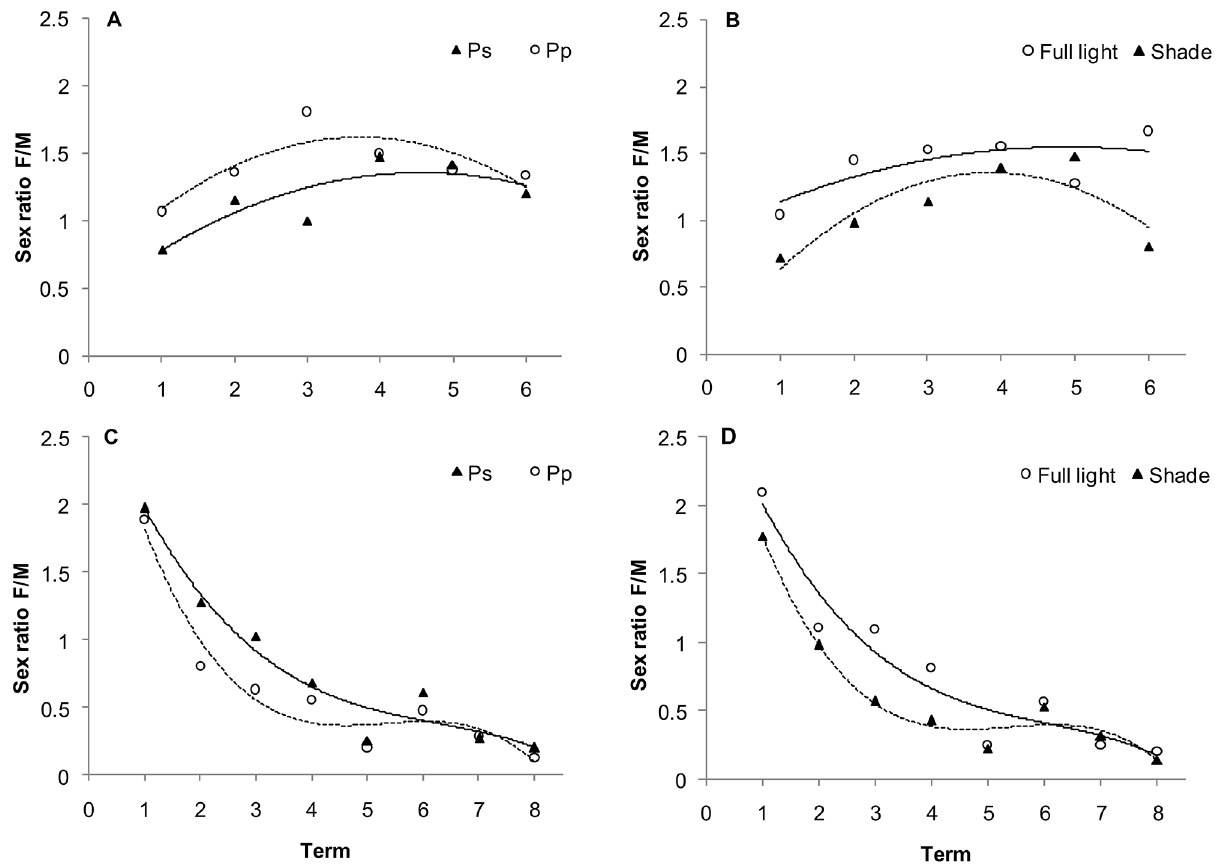
Fig 3. Sex ratio of current-year (A and B) and 1-year-old (C and D) Gonioctena quinquepunctata beetles on Prunus padus (Pp) and Prunus serotina (Ps) shrubs growing in full light or shade (B and D). Numbers 1 – 6 and 1 – 8 indicate successive dates of insect collection (see Materials and Methods). One-way ANOVA was used to determine the effect of term (length of the sampling period) on the sex ratio of beetles on Ps (current-year, R 2 = 0.2477, P = 0.1111; 1-year-old, R 2 = 0.7098, P < 0.0001), on Pp (current-year, R 2 = 0.1884, P = 0.2551; 1-year-old, R 2 = 0.7661, P < 0.0001), on sunlit shrubs (current-year, R 2 = 0.1286, P = 0.5031; 1-year-old, R 2 = 0.8441, P < 0.0001) and shaded shrubs (current-year, R 2 = 0.4109, P = 0.0053; 1-year-old, R 2 = 0.8590, P <